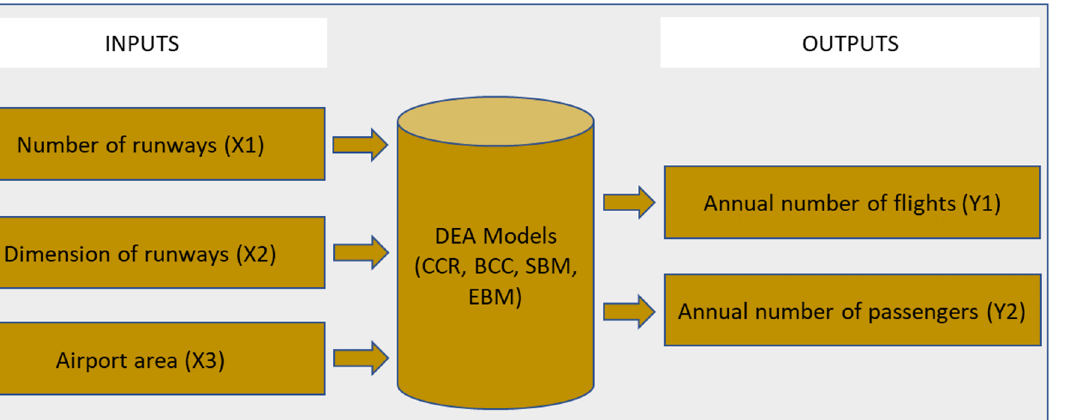
Figure 2. Inputs and outputs used in the DEA models.